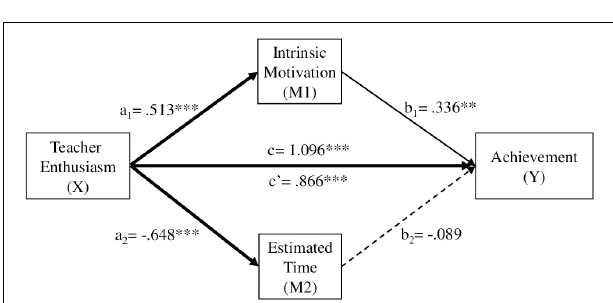
FIGURE 3 | Analysis of mediation through intrinsic motivation and estimated time as a function of teacher enthusiasm over achievement. a 1 , a 2 , b 1 , b 2 , c’ = path coefficient (unstandardized coefficient). * p < 0.05, ** p < 0.01, *** p < 0.001. Direct effects B = 0.866, SE = 0.194, t = 4.475, p <